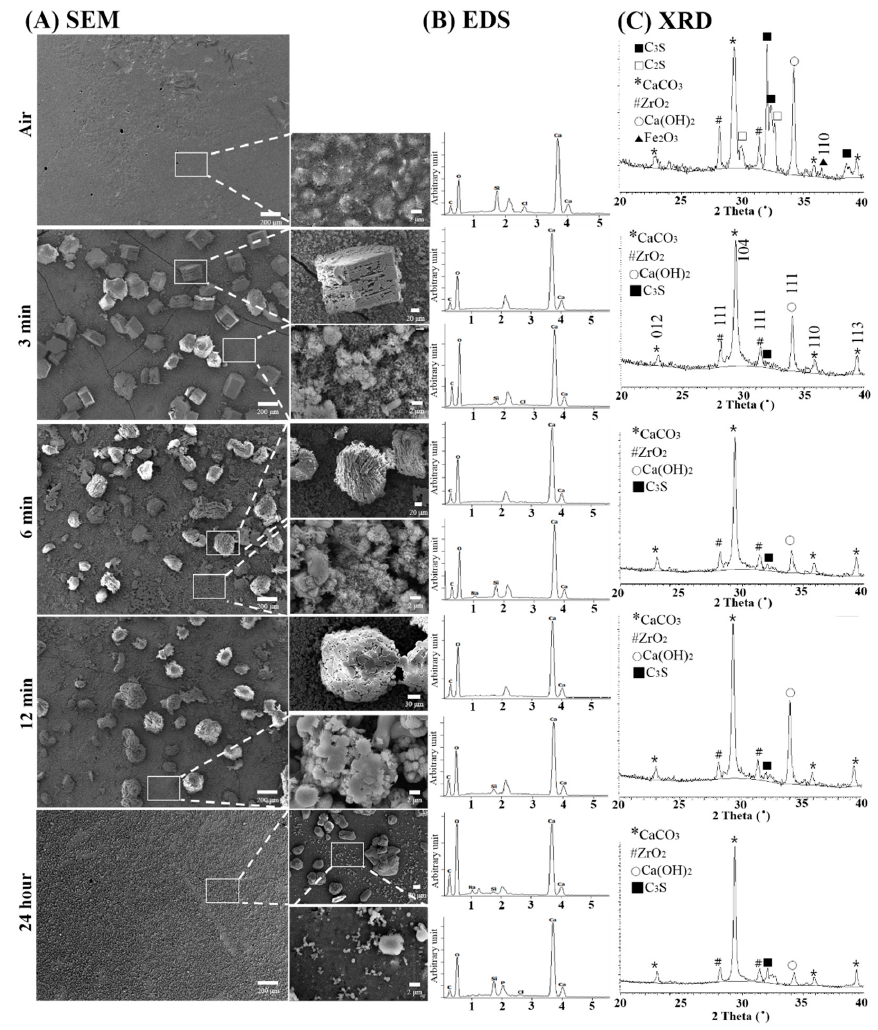
Figure 2. Physical analysis of tricalcium silicate nanoparticle-containing cement (Biodentine™) surface dried in the air for 24 h (Air) or immersed in medium for 24 h after setting for 3, 6 or 12 min or 24 h. ( A ) Scanning electron micrographs (×100, 500, 800, 10,000) of the Biodentine™ surface show a relatively uniform flat surface without microstructural particles for samples that had been in the air for 24 h, while the 3, 6 and 12 min and 24 h groups exhibited rough surfaces with various particles of different sizes in the micrometer range. ( B ) Energy-dispersive spectroscopy analysis revealed that calcium, oxygen and carbon were present in the scattered particles, but surface silicon was also present in the matrix. There was no significant difference in the exhibited elements according to the setting time (3, 6 and 12 min and 24 h groups). ( C ) X-ray diffractograms of Biodentine™ showed that the different phases tricalcium silicate, dicalcium silicate, calcium carbonate, zirconium oxide and calcium hydroxide are components of the 24 h air-dried Biodentine™ specimens; however, the 3, 6 and 12 min and 24 h groups exhibit mainly calcium carbonate, zirconium oxide and calcium hydroxide components, and there is a very small peak of tricalcium silicate for the 3, 6, 12 min and 24 h group. For Biodentine™, a close up of the 2 θ region from 20° to 40° with a sampling width of 0.02° and a scan speed of 0.5°/min is shown embedded in the image.